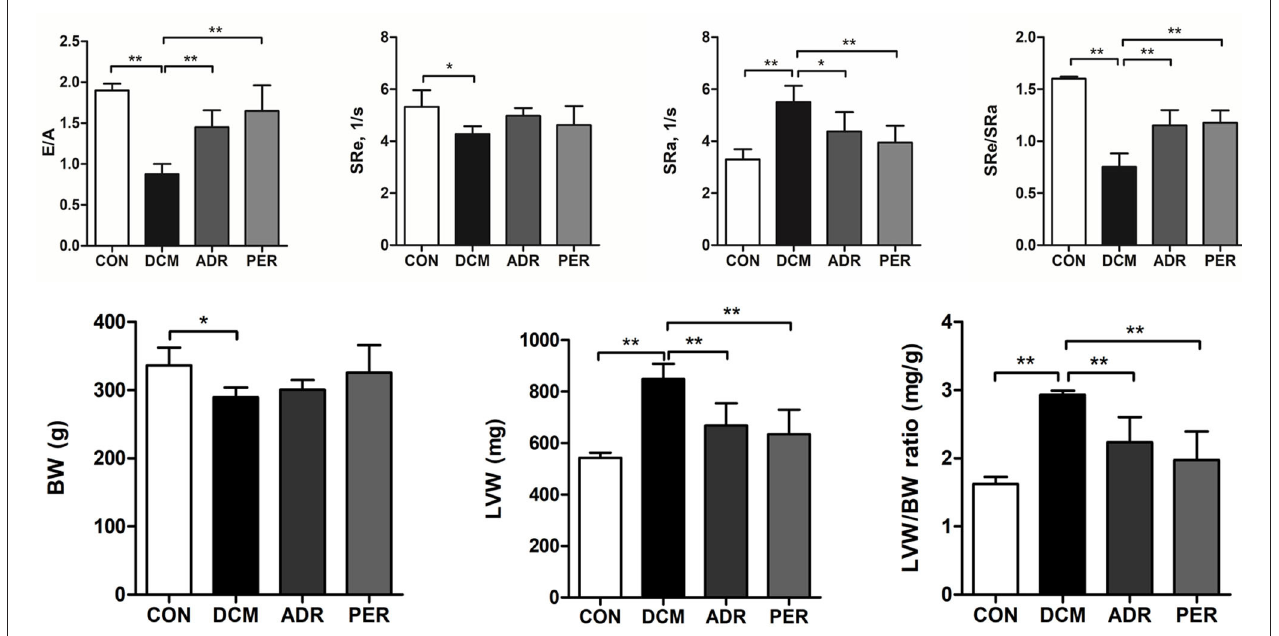
FIGURE 1 | Effects of ADR on diastolic function and LVW/BW ratio in DCM rats. E/A ratio and SRe/SRa ratio dercreased in DCM group compared with CON group. Compared to DCM group, E/A ratio and SRe/SRa ratio increased significantly in ADR group. Compared to CON group, LVW/BW ratio increased in DCM group. ADR can decrease LVW/BW ratio significantly. It also decreased in PER group, compared with DCM group. CON, control; DCM, diabetic cardiomyopathy; ADR, adropin; PER, perindopril; E/A, ratio of peak velocity of early (E) to late atrial (A) mitral flow. SRe and SRa, strain rate in early and late diastole, respectively. LVW, left ventricular weight; BW, body weight. Values are expressed as mean ± standard deviation. * P < 0.05, ** P < 0.001.